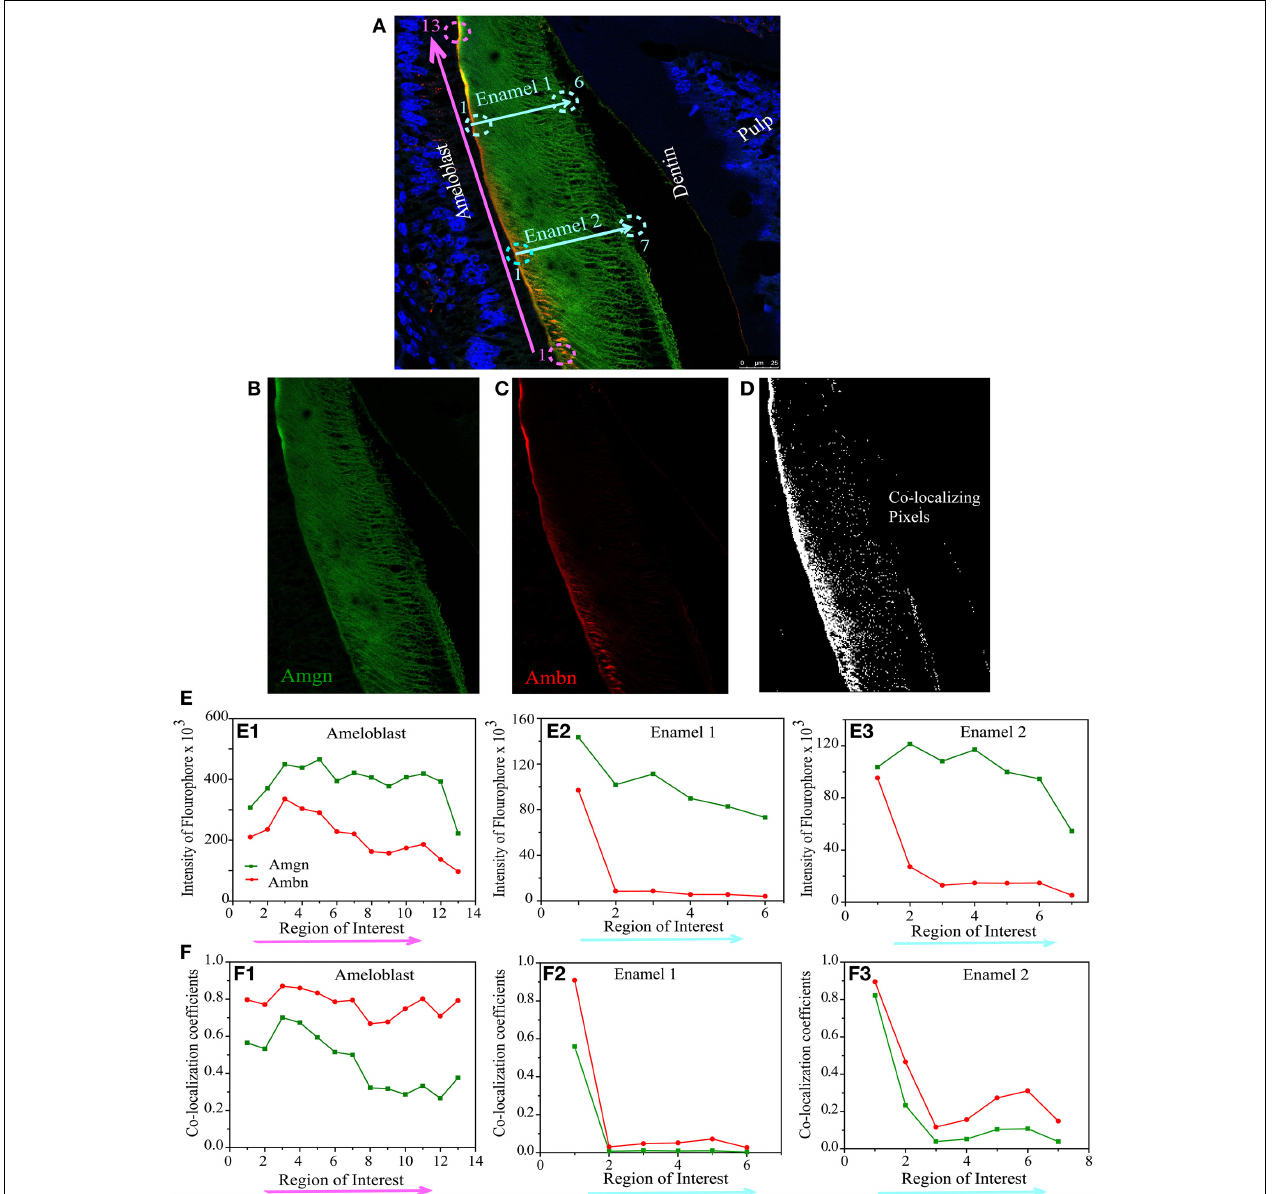
FIGURE 6 | Quantitative co-localization of ameloblastin and amelogenin in mouse molar enamel at P8. (A) Confocal image with higher magnification taken from the sample in Figure 4C (see square), considered for QCA analysis along the enamel surface (pink arrow) and enamel thickness (cyan arrows). The individual channels detecting (B) only Amgn and (C) only Ambn signal. (D) Represents co-localization pattern after analysis of image